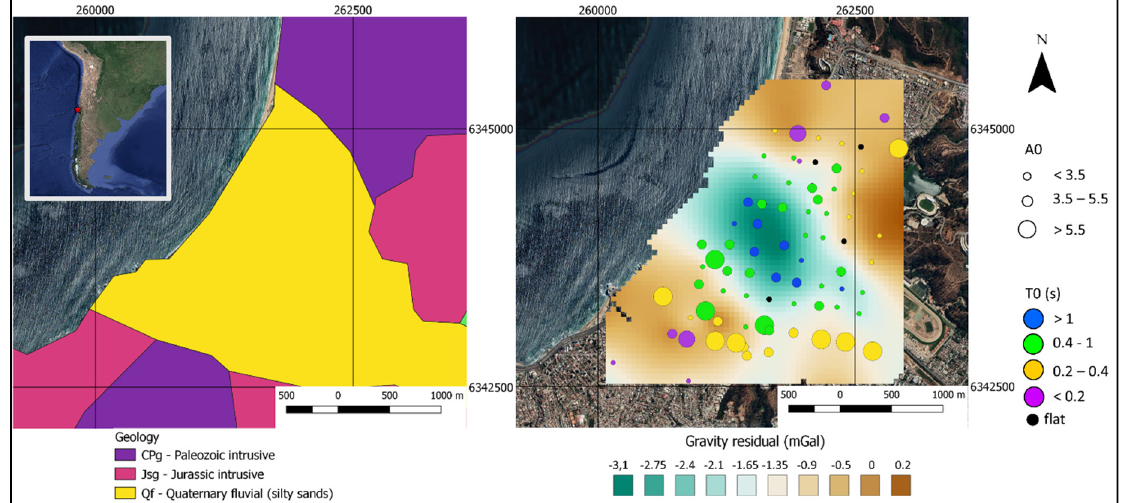
Figure 5. Viña del Mar. Left panel: Simplified geology of the city adapted from Chilean geological map 1:1,000,000 [36]. Right panel: Main results of the geophysical campaign [24,36]. The color grid shows the gravity residuals in mGal. The color points show the H/V results. Color indicates the predominant period (T0) in seconds and the size indicates the amplitude (A0) of the H/V curve.